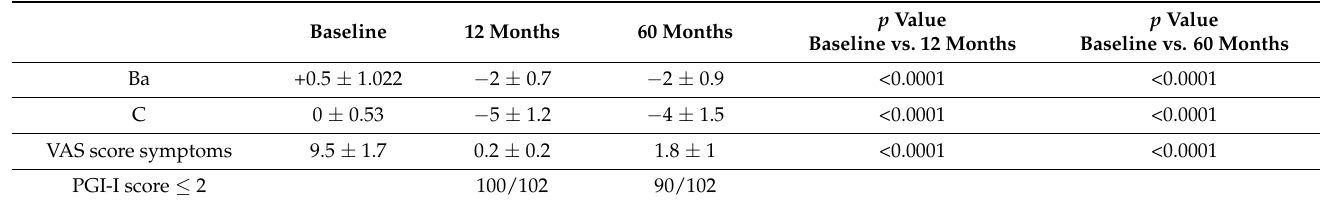
Table 5. Anatomical and clinical results at 12 months and 60 months follow-up.